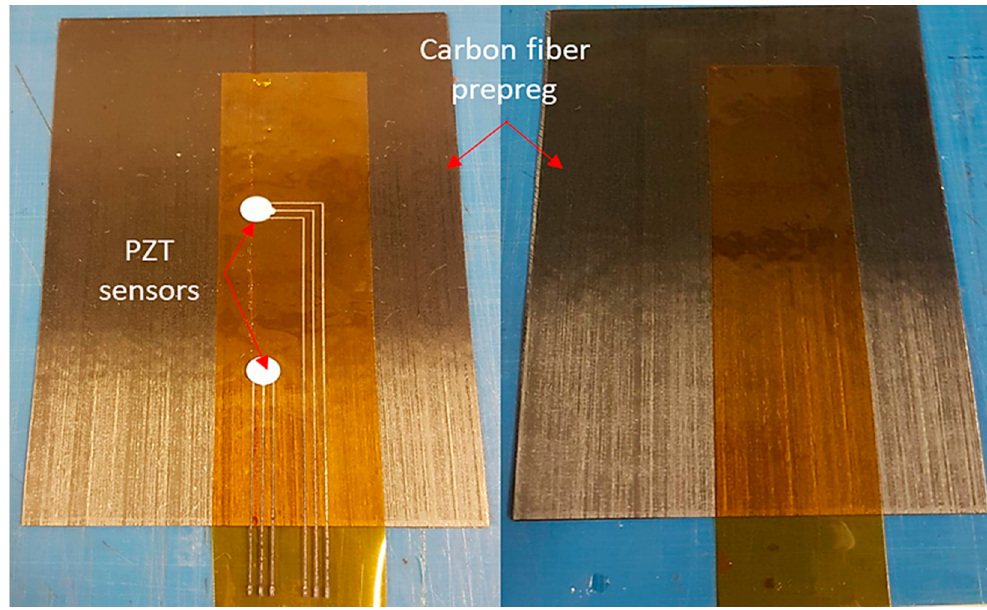
Figure 14. Thin film embedded within a CFRP interlayer.